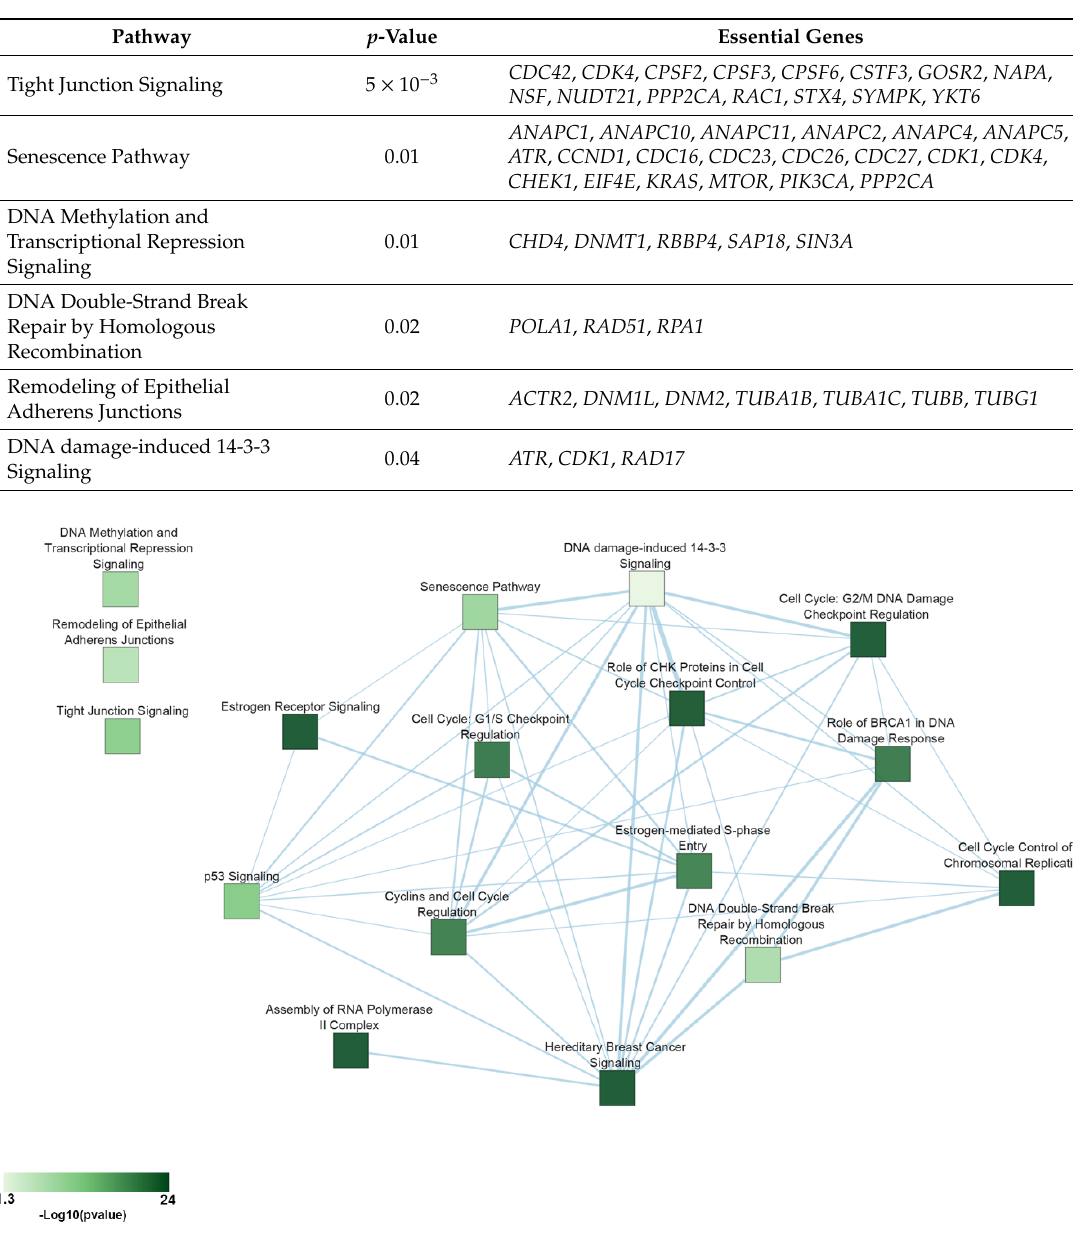
Figure 2. Canonical pathway enrichment analysis involving ER α + BC essential genes. Network summarizing the canonical pathways involving key genes found essential in the genome-wide dropout screenings considered here. Edges between nodes (light blue lines) were generated using an overlap coefficient of 0.3 and their width is proportional to the number of shared genes.